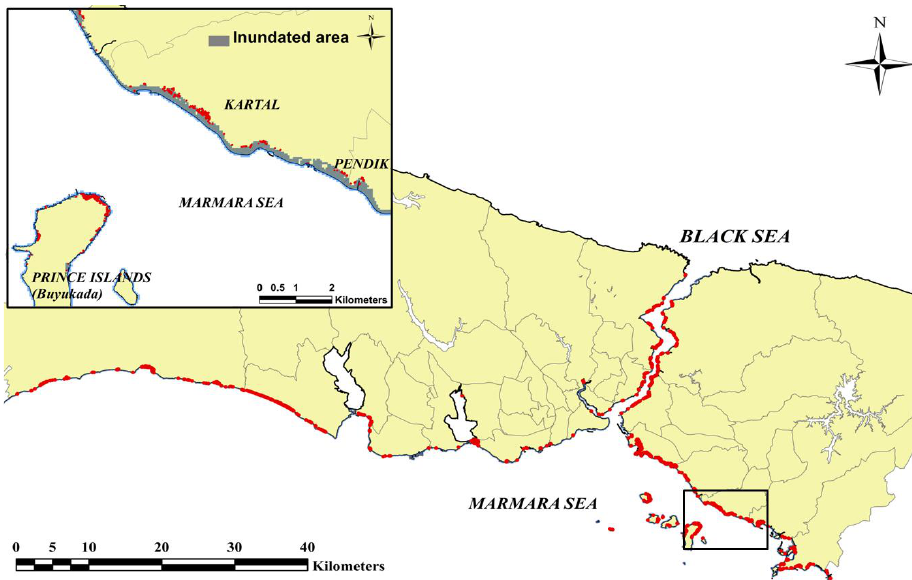
Figure 7. Spatial distribution of the residential buildings at risk: Buildings highlighted by red. Embedded frame: A closer view of the inundated 2 Fig. 7. Spatial distribution of the residential buildings at risk: buildings highlighted by red. Embedded frame: a closer view of the inundated areas where the residential buildings are densely located. 3 areas where the residential buildings are densely located.